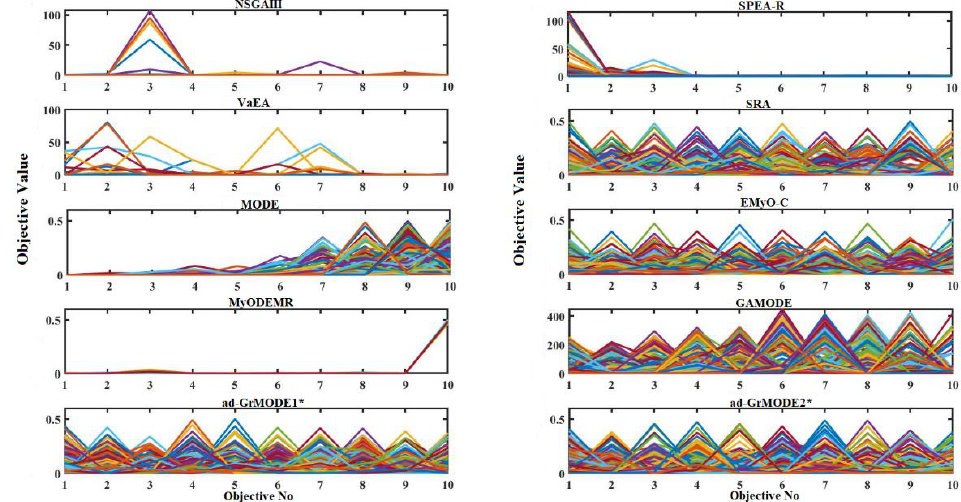
Figure 5. A parallel set of coordinates corresponding to the different Pareto front algorithms on the 10-objective DTLZ1 problem.